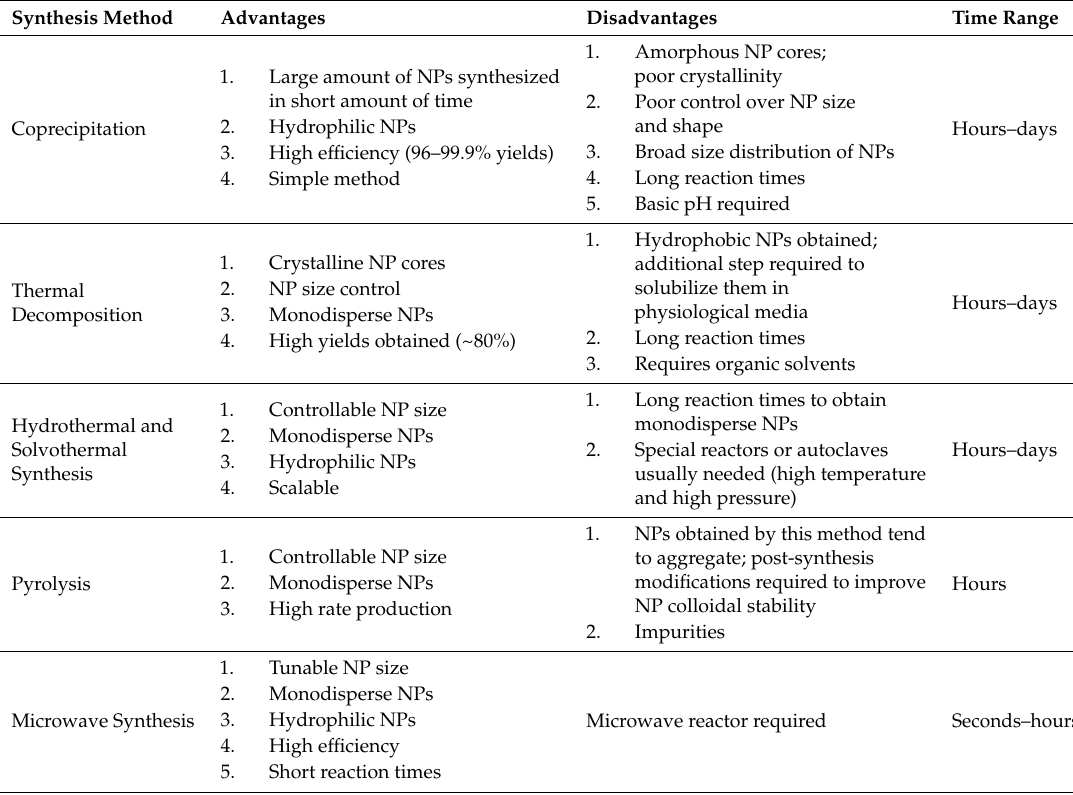
Table 1. Iron-oxide nanoparticle (IONP) synthesis methods, and their advantages and